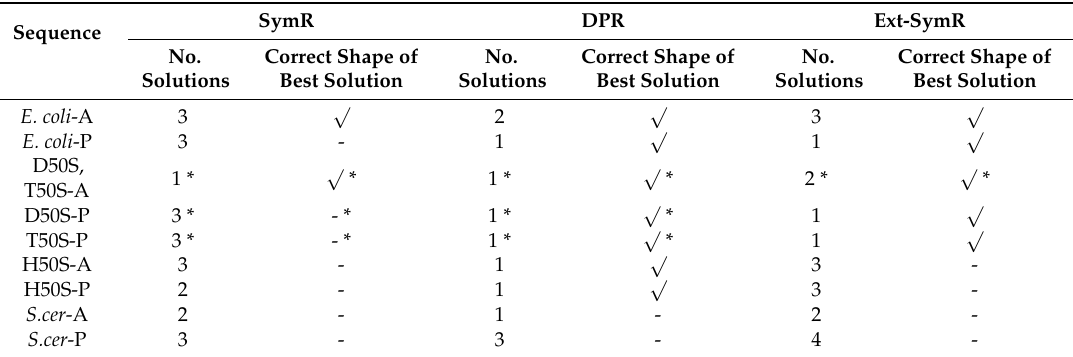
Table 1. Results of the secondary structure predictions of the A-, P-monomeric sequences from the suggested proto-ribosomes from bacterial ( E. coli , D50S, T50S), archaeal (H50S) and eukaryotic ( S. cer ) ribosomes. * indicate that the sequences of T50S and D50S are identical in that region, generating identical